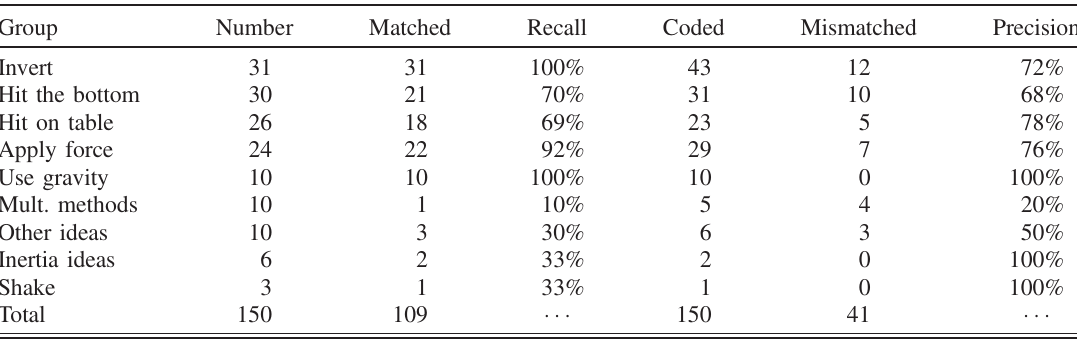
TABLE V. Group-by-group matching for the coin stuck in a graduated cylinder activity. Group